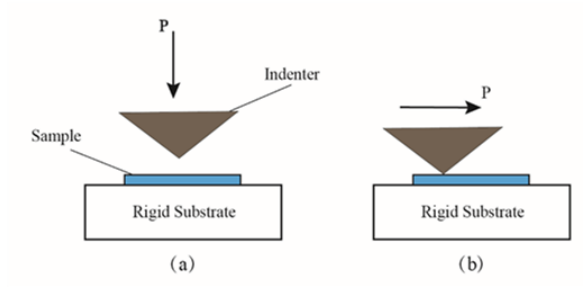
Figure 1: (a) schematic diagram of nanoindentation test process; (b) schematic diagram of the nanoscratch test